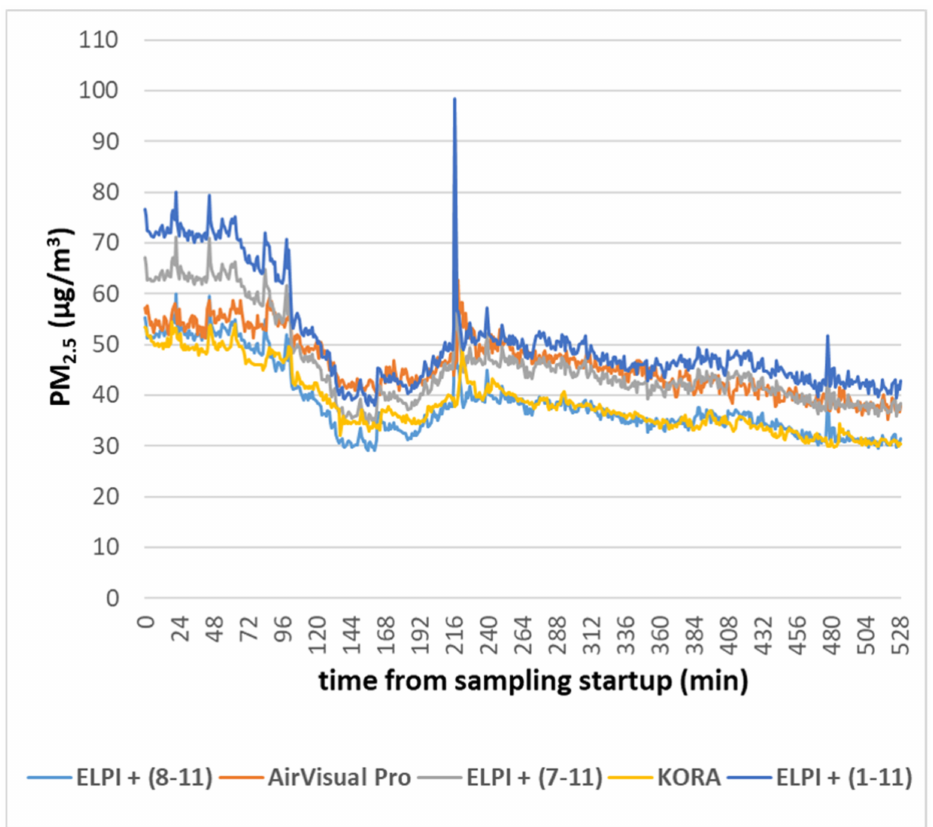
Figure 7. PM 2.5 daily concentration patterns measured by AirVisual Pro, KORA, and ELPI+, the latter identified by the range of fractions (min–max)